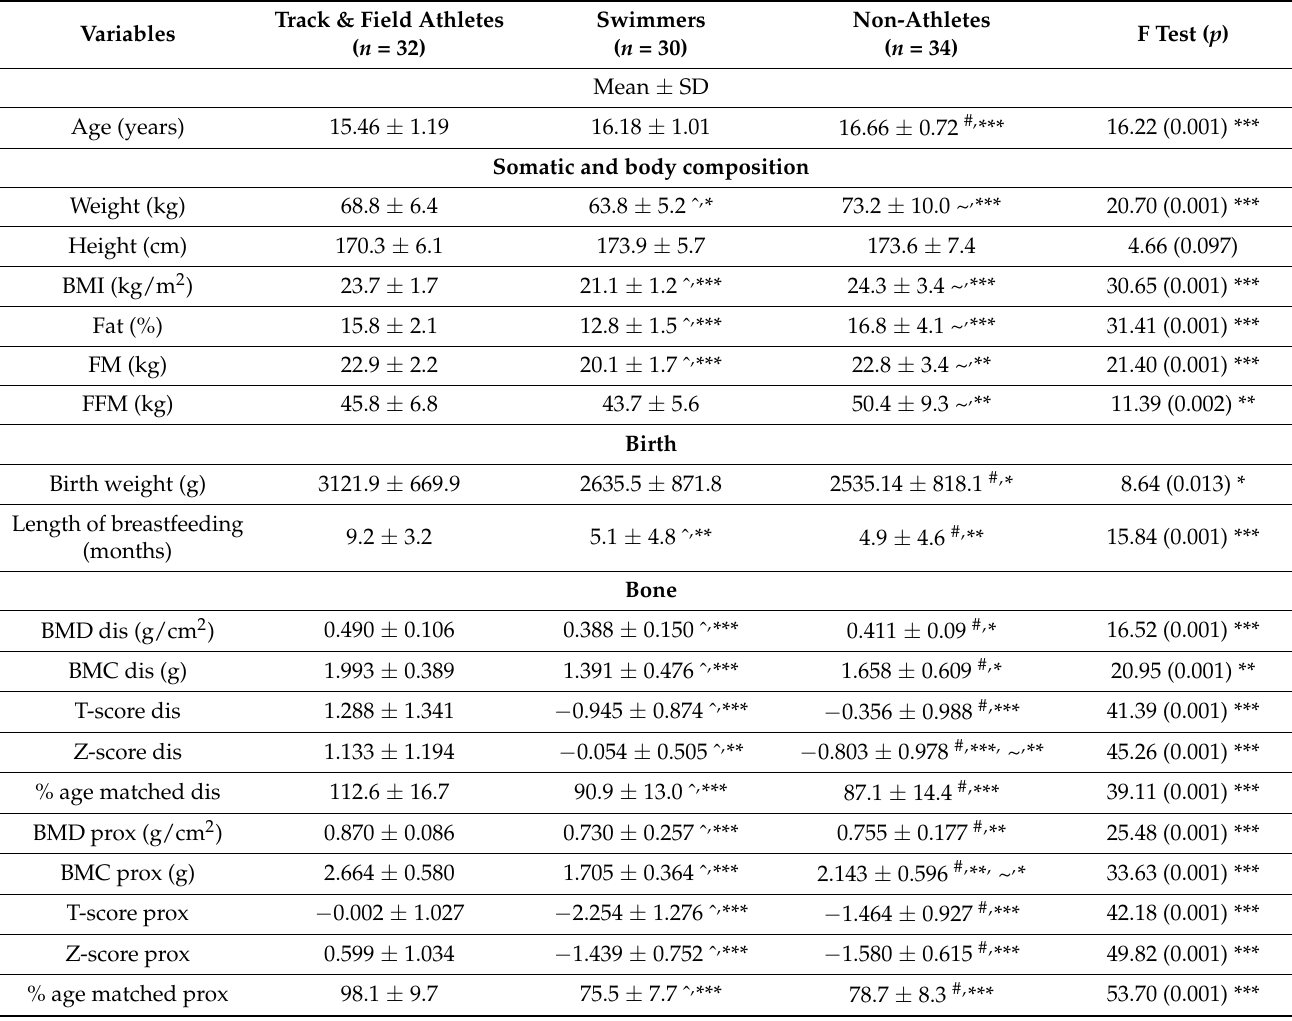
Table 1. Characteristics of study population ( n = 96) (results of Kruskal-Wallis test and multiple comparisons of mean